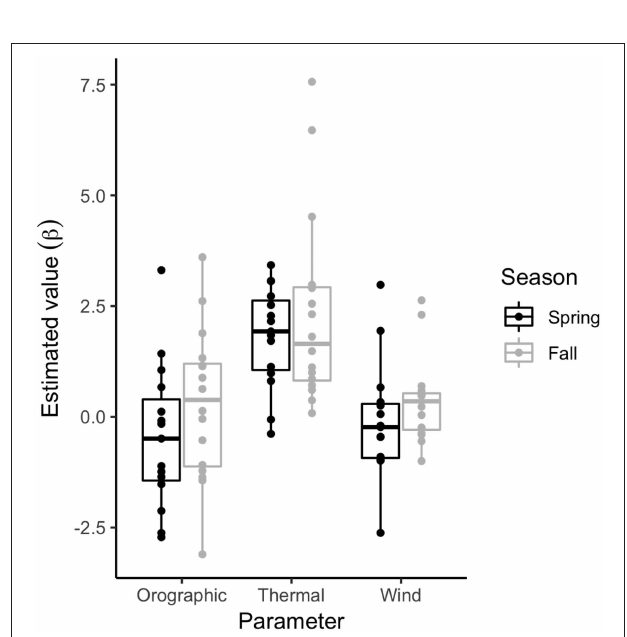
FIGURE 4 | Point estimates of environmental covariate effect parameters ( β ou , β tu , β tw ) on golden eagle behavior and movements during migration ( N = 15 spring and N = 16 fall). Estimates are from the correlated random walk model with full behavioral process, including orographic uplift, thermal uplift, and wind support as predictors.